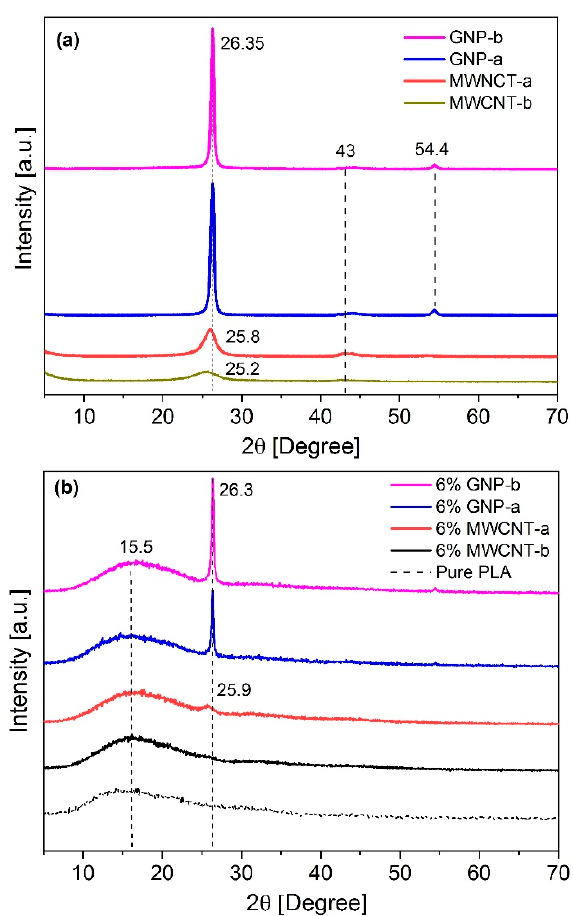
Figure 4. WAXD diffraction of ( a ) fillers, graphene (GNP-a and GNP-b) and carbon nanotubes.(MWCNT-a and MWCNT-b); ( b ) nanocomposites with 6 wt.% fillers of GNP-a, GNP-b, MWCNT-a, and MWCNT-b with the neat PLA, as a